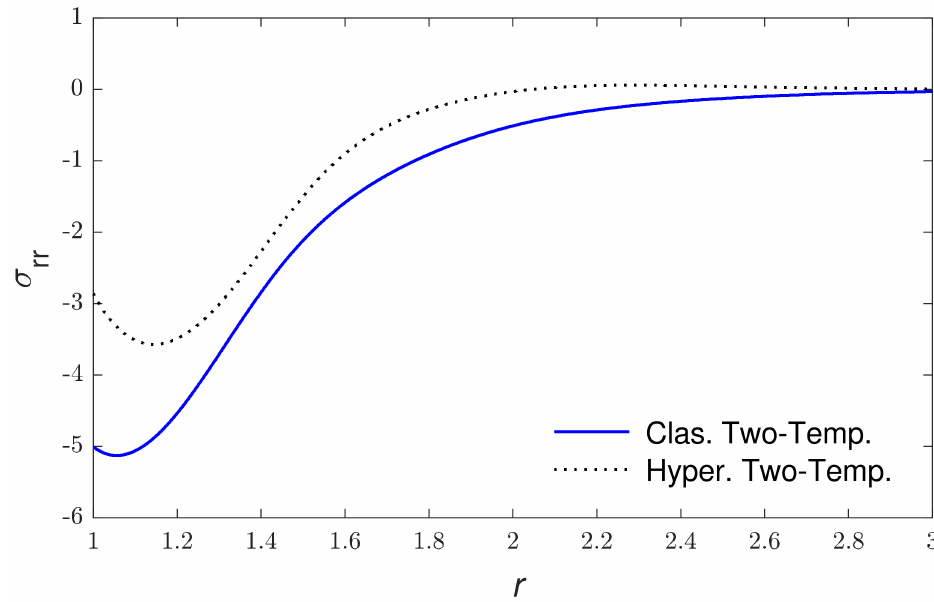
Figure 6. The radial stress variations versus the redial distance.